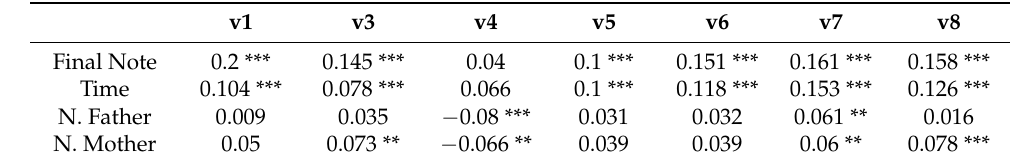
Table 5. Goodman and Kruskal gamma test. Perception of competences in terms of what has been learnt. v1 v3 v4 v5 v6 v7 v8 Final Note 0.2 *** 0.145 *** 0.04 0.1 *** Time 0.104 ***